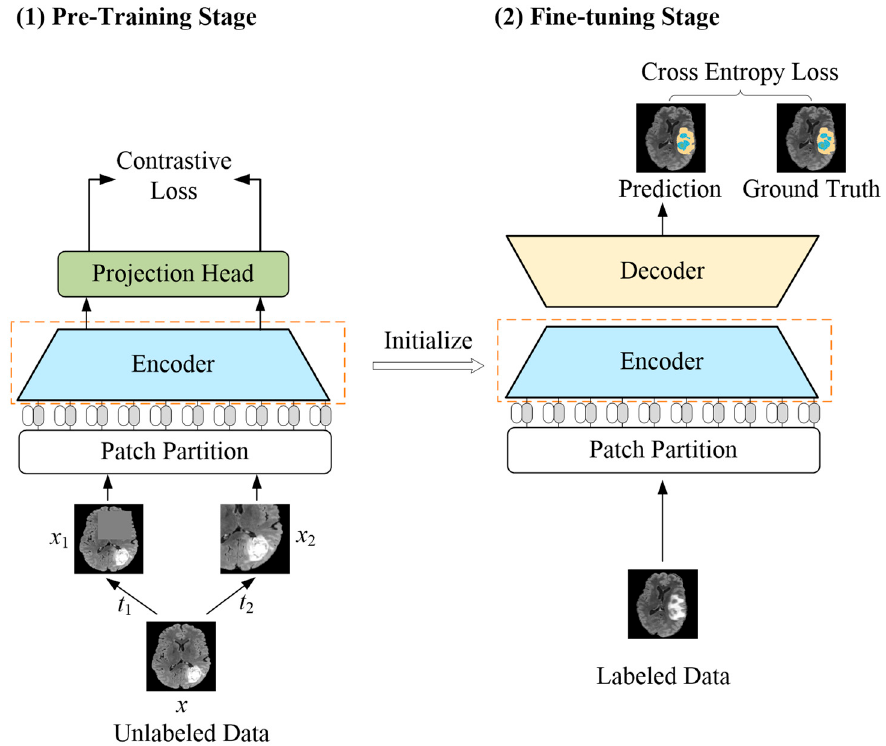
Figure 1. Overview of the proposed LETCP method. In pre-training stage, input image x with random augmentation t 1 and t 2 to obtain enhanced images x 1 and x 2 . The pre-trained encoder serves as initialization of fine-tuning stage for segmentation prediction .